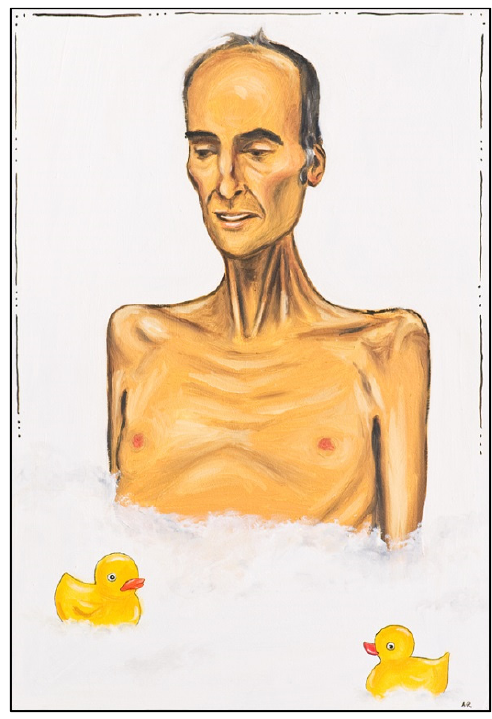
Figure 2. Last bath with ducks.